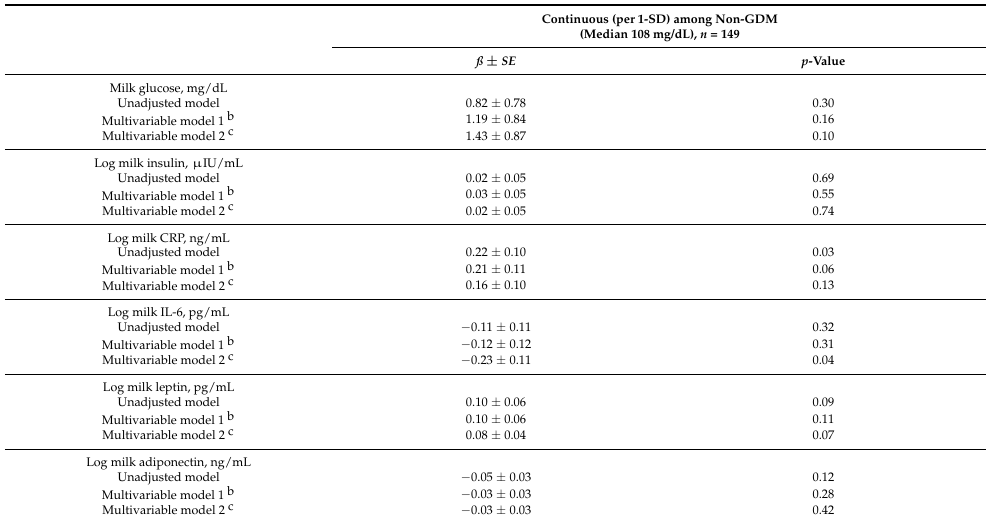
Table 3. Association of OGCT result at 1 h and human milk hormone and cytokine concentrations at 1 month in women without GDM a